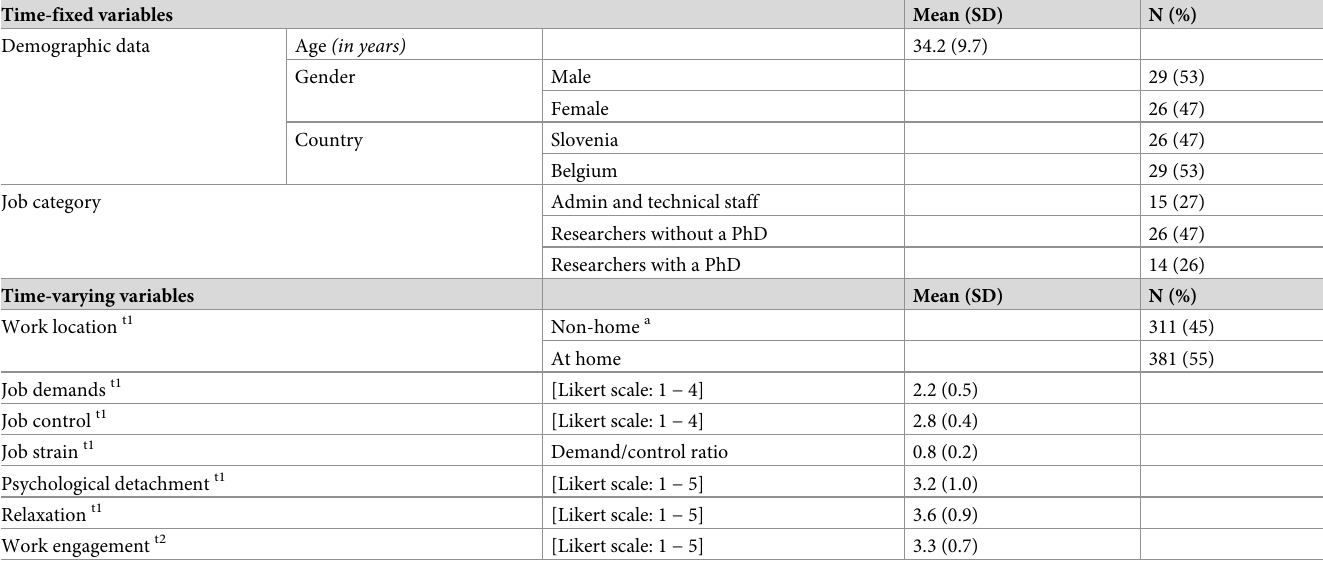
Table 1. Descriptive statistics of the study sample (N = 55). [number of item measurements = 2710; SD = standard